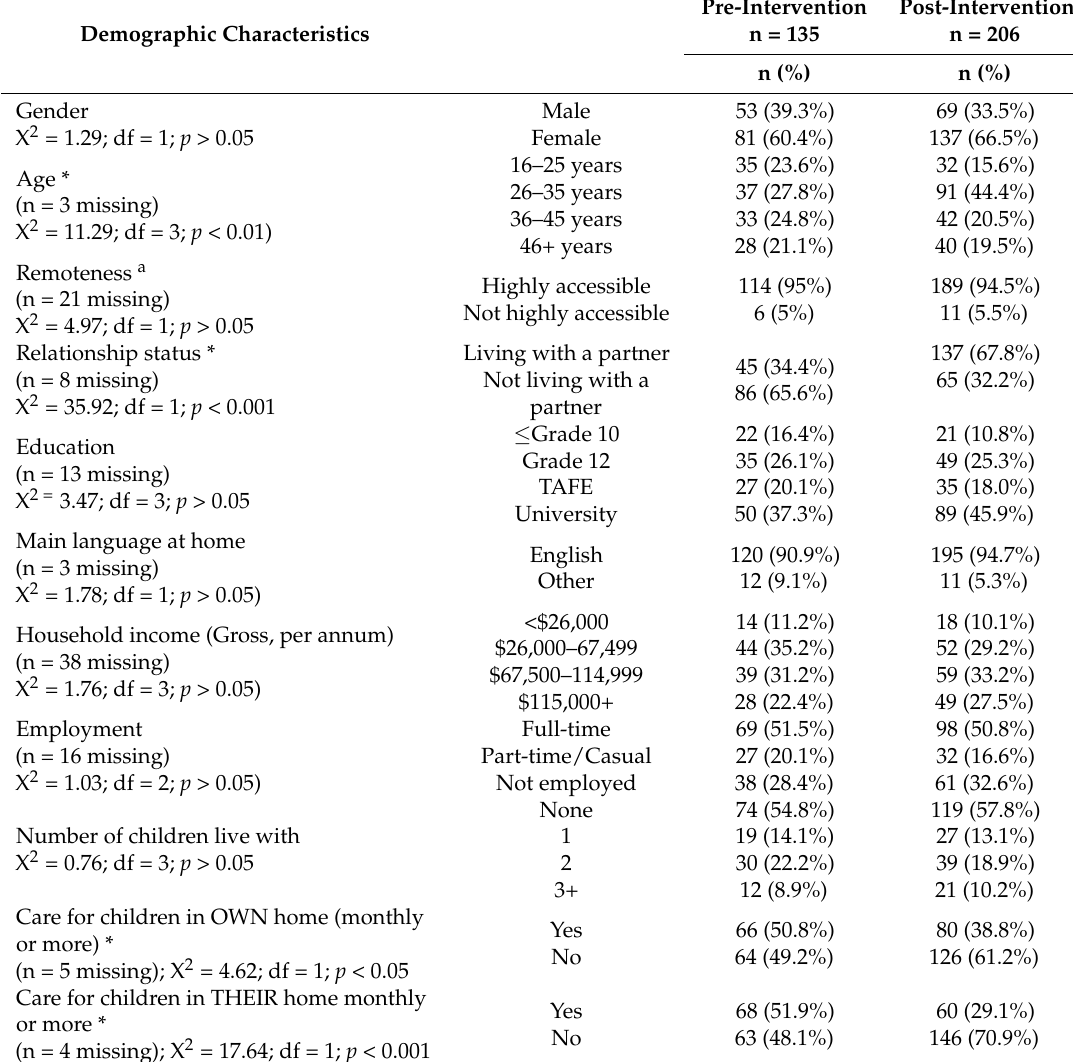
Table 1. Population-Based Survey Sample